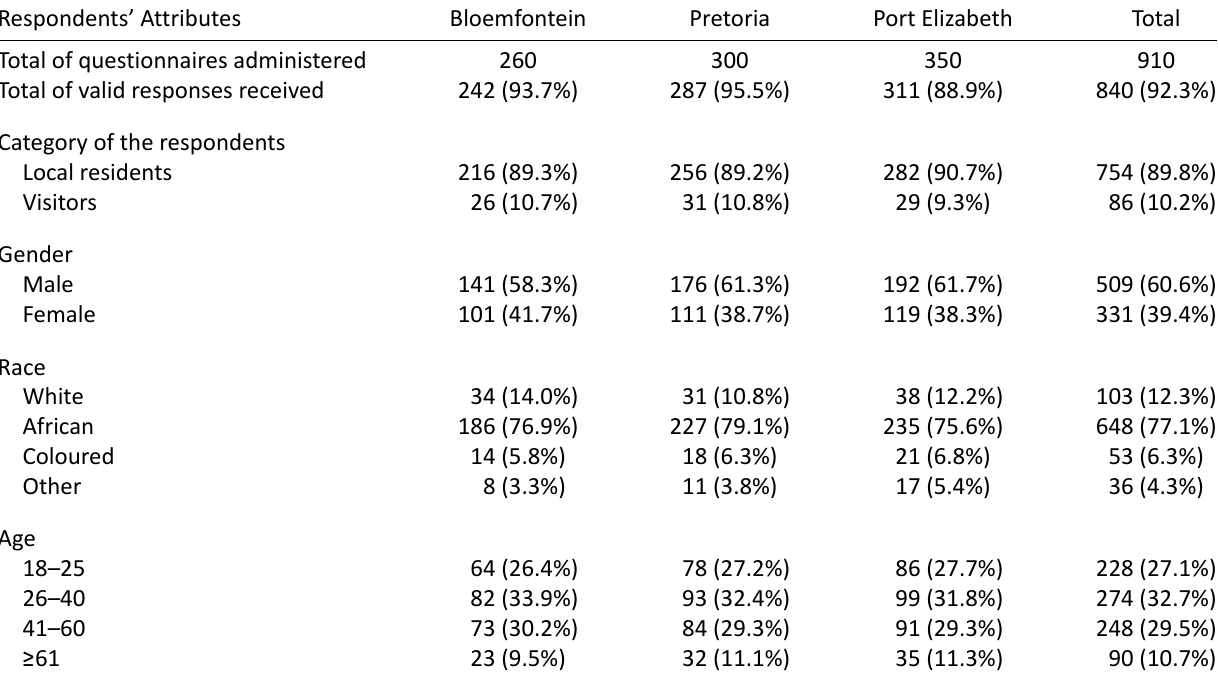
Table 1. Summary of the profile of